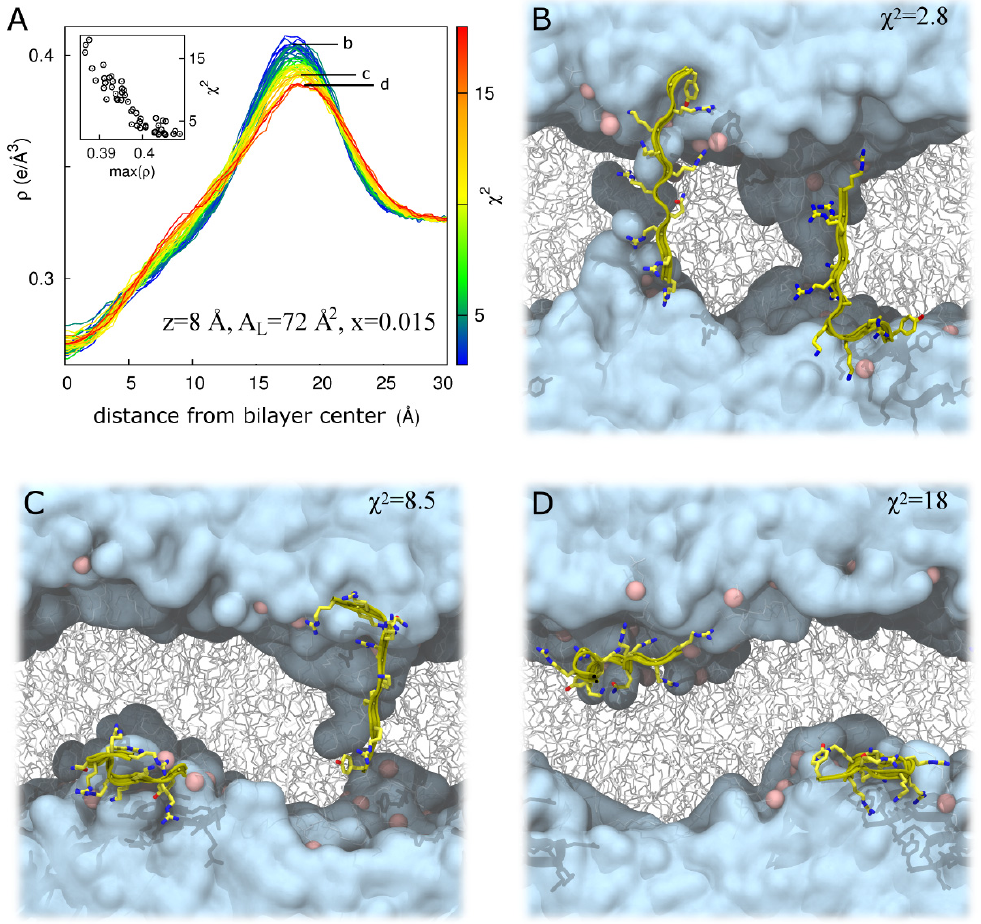
Figure 7. Bilayer undulations increase χ 2 in DOPC:DOPE (1:1) at z = 8 Å, A L = 72 Å 2 for a Tat 47–57 mole fraction of 0.015. ( A ) Total system electron density, ρ , as a function of absolute distance from the global bilayer center along its global normal for N = 52 simulations, colored by χ 2 value representing a range from best (blue) to worst (red) fit to experiment. Inset, χ 2 as a function of the maximum value of ρ . Labels b, c, and d in part A identify electron density curves for systems whose snapshots are shown in parts B, C, and D, respectively. ( B – D ) Snapshots after 100 ns of simulation in repeats with χ 2 values of 2.8 ( B ); 8.5 ( C ); and 18 ( D ). Water is cyan, lipids are gray, lipid headgroup phosphorus atoms are pink, and protein is yellow. Protein is rendered in front of all other molecules for